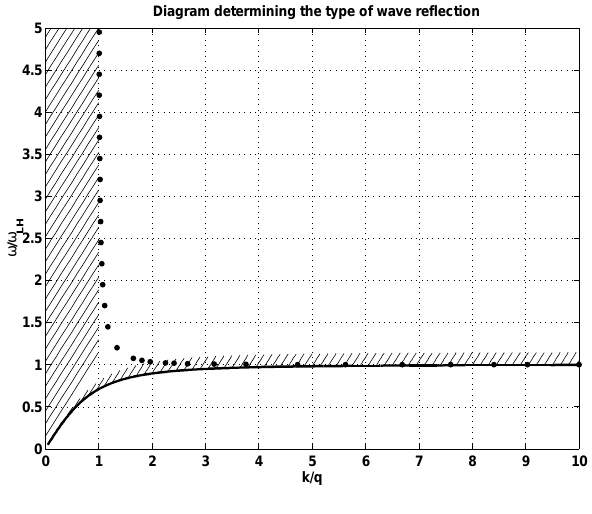
Fig. 2. Reflection